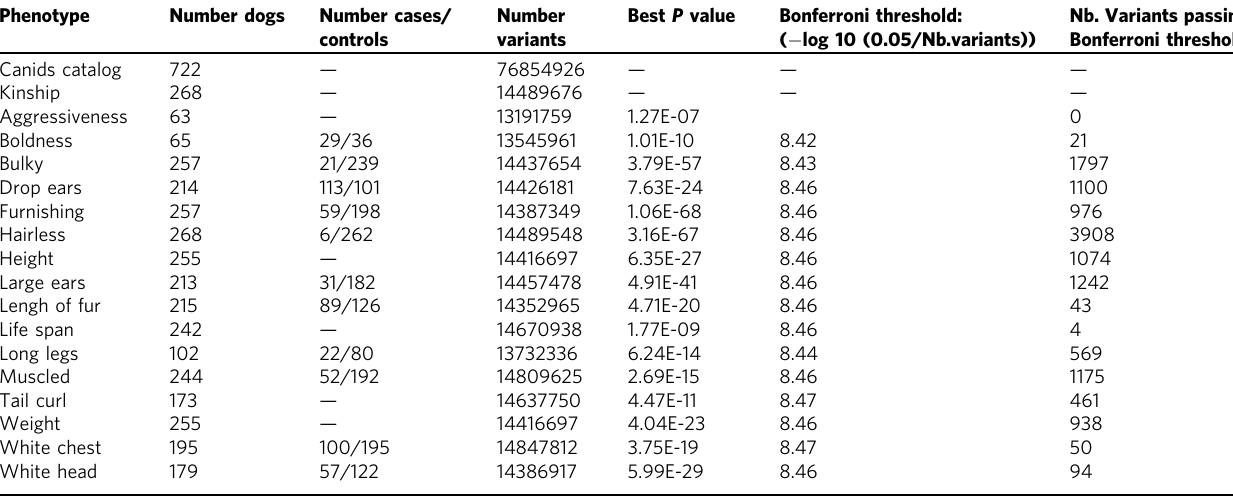
Table 1 Summary of phenotypes used to perform GWAS using the WGS catalog